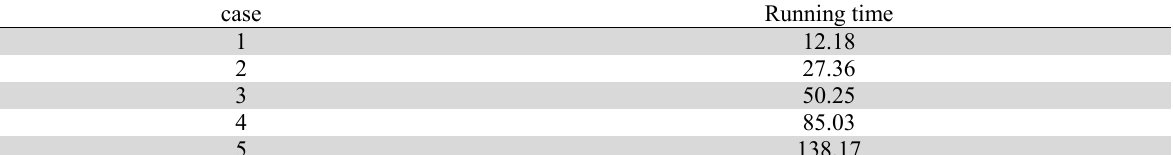
Running time of numerical example